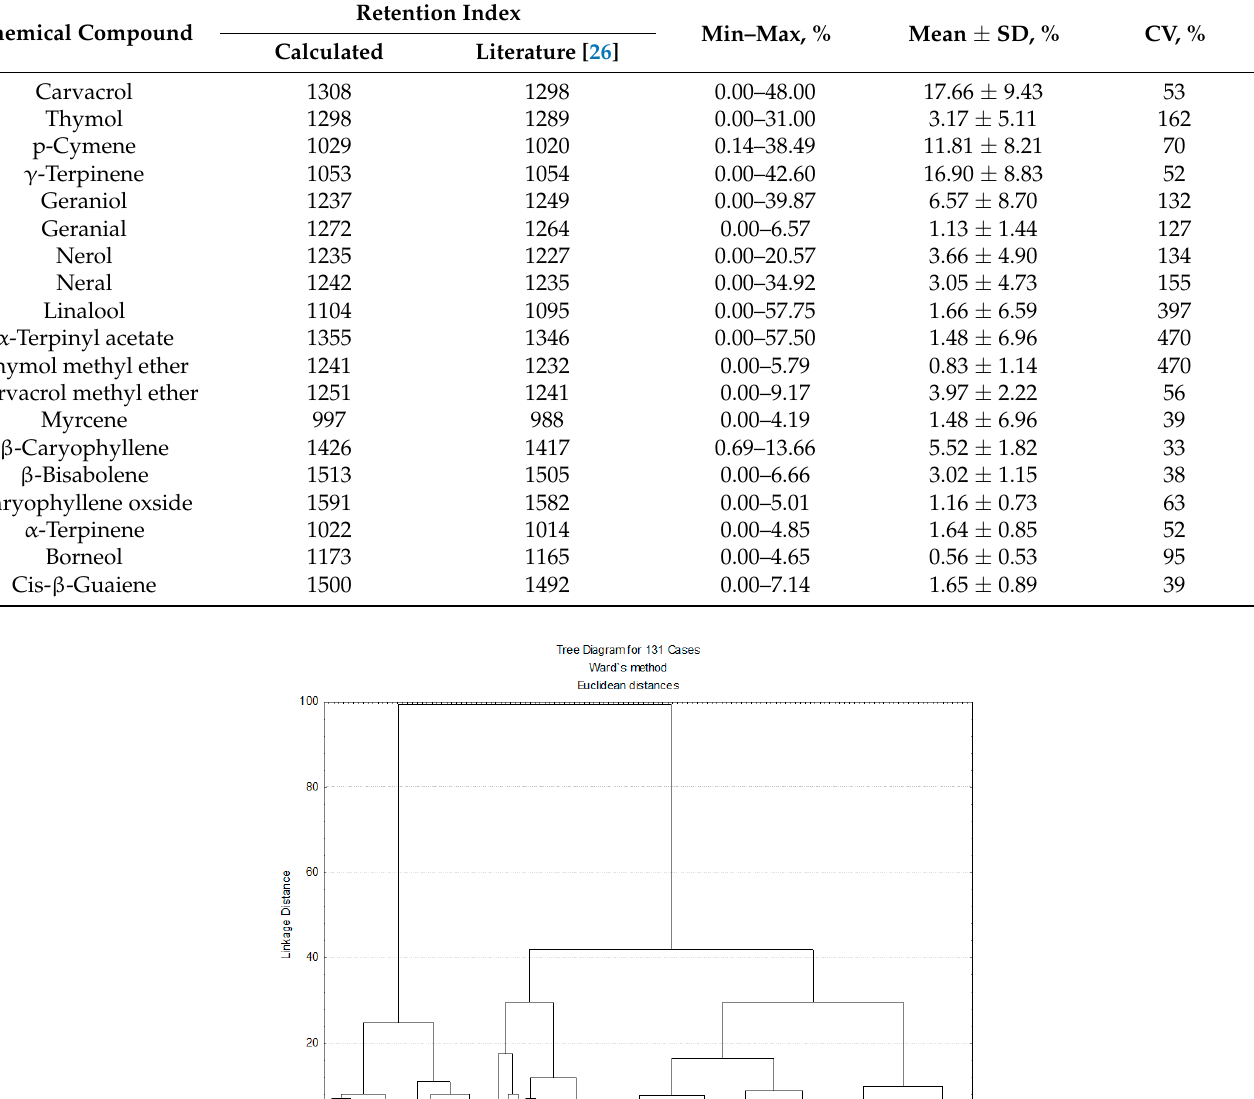
Table 1. Descriptive statistics of chemical compounds (the percentage of which exceeded for leastways